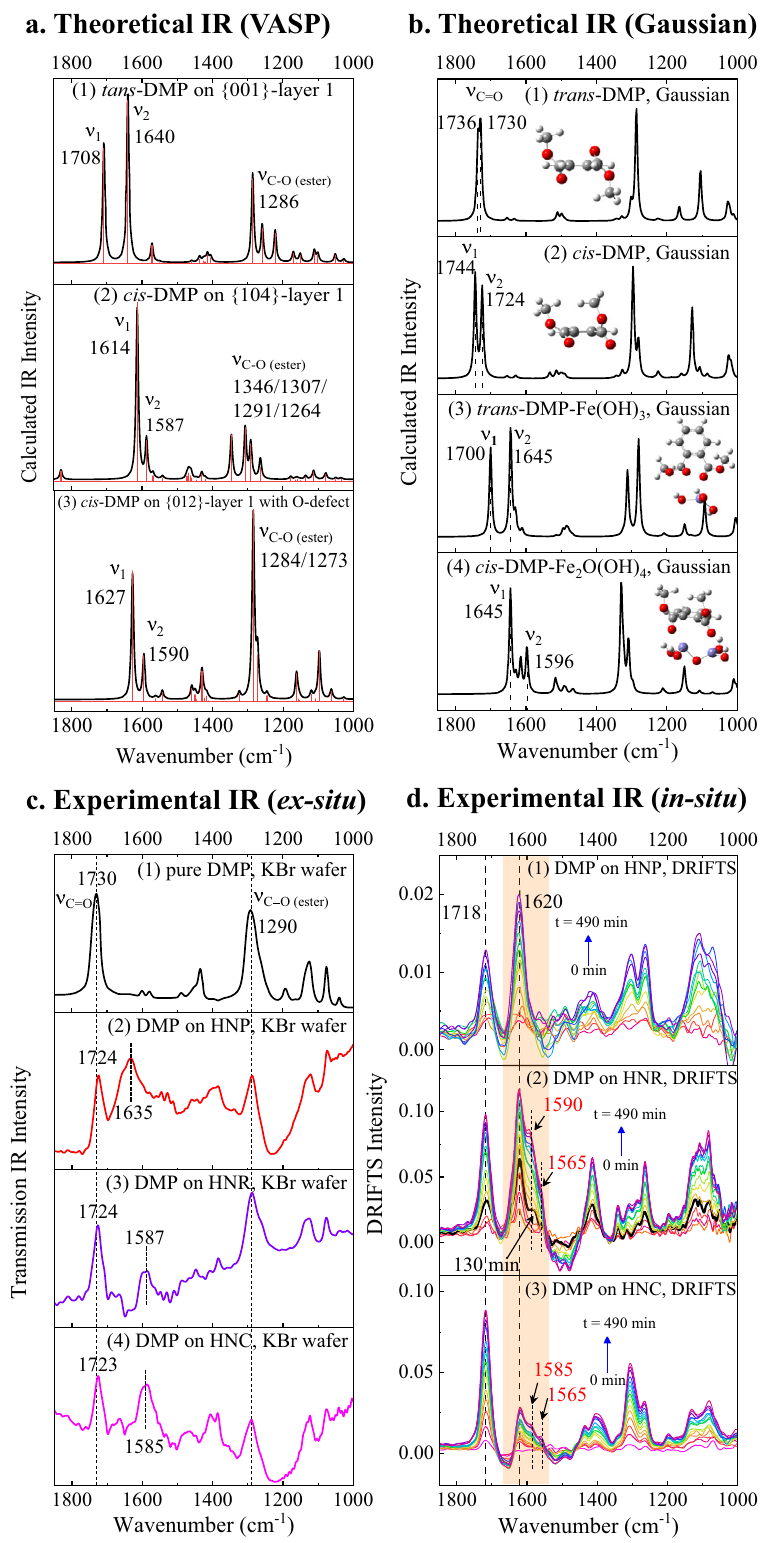
Fig. 5 | IR spectra comparison between theoretical and experimental ones. a The theoretical IR spectra of trans -/ cis -dimethyl phthalate (DMP) on the three facets by VASP calculation. b The theoretical IR spectra of trans -/ cis -DMP before and after complexing with Fe(OH) 3 or Fe 2 O(OH 4 ) cluster, by Gaussian calculation. The insets are the optimized molecular geometries. c The experimental IR spectra of DMP before and after adsorption onto hematite nanoplate (HNP), hematite